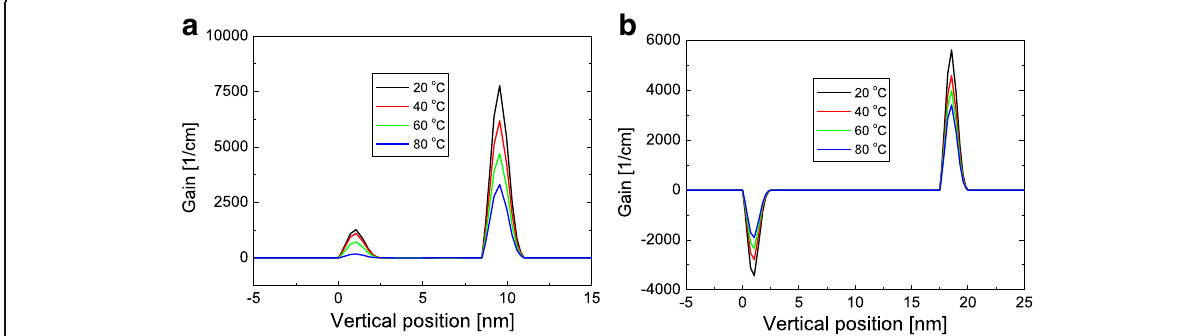
Fig. 8 Gain concentration distribution at 30 mA for temperatures of 20, 40, 60, and 80 °C when the barrier thicknesses are a 6 and b 15 nm. The T 0 value for each doping concentration is shown. Here, barrier doping concentration is fixed at 1 × 10 18 cm −